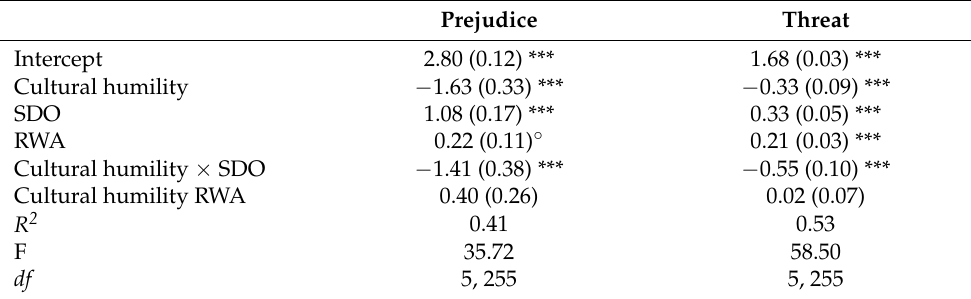
Table 2. Regression analysis predicting prejudice and threat.